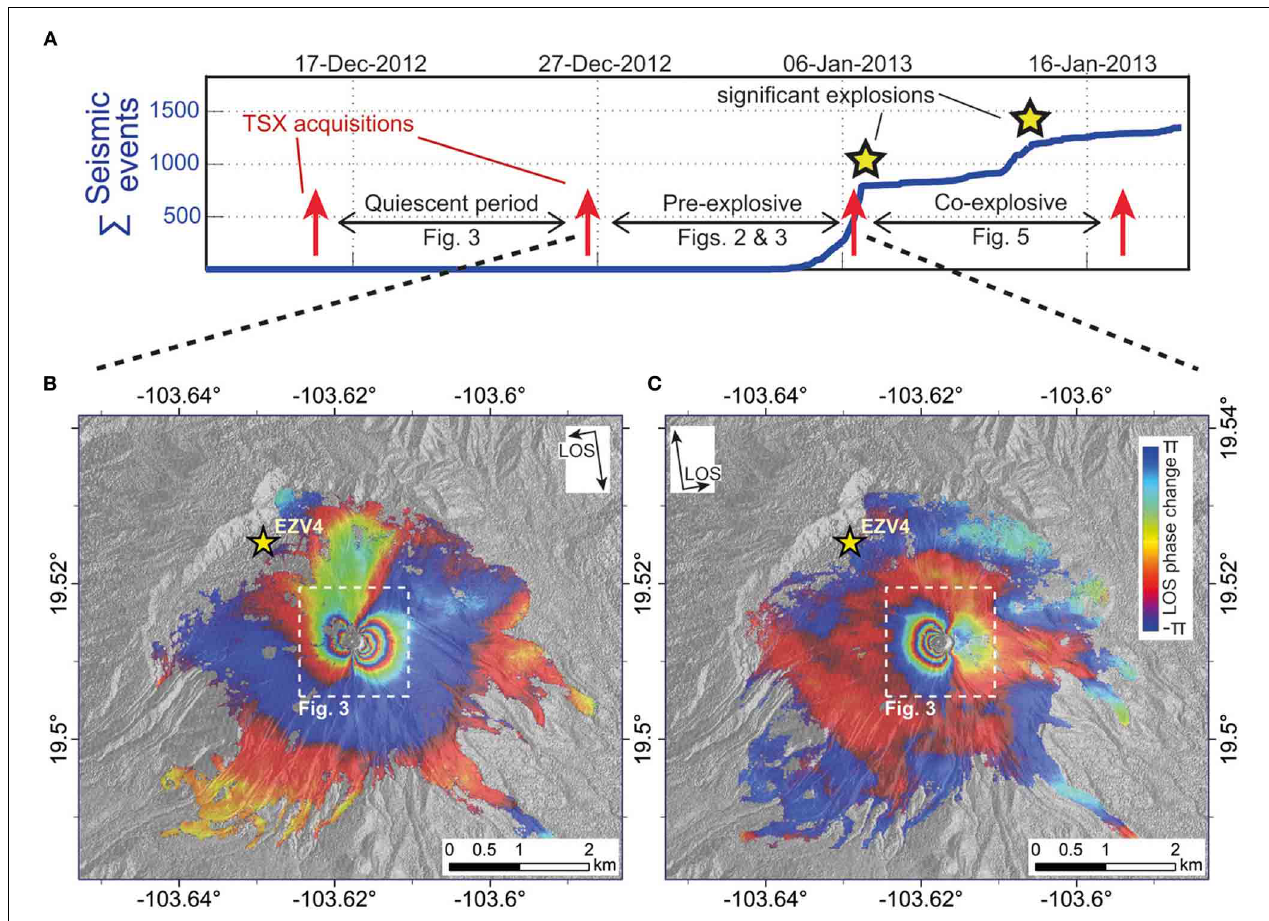
FIGURE 2 | Seismicity increase in January 2013 and TerraSAR-X interferograms. (A) Time plot with cumulative number of seismic events recorded at EZV4 (blue), timing of TerraSAR-X satellite acquisitions (red arrows) and timing of significant explosions (yellow stars). The interferograms cover the quiescent period, the pre-explosive period and the co-explosive period. (B,C) The re-wrapped pre-explosive interferograms (December